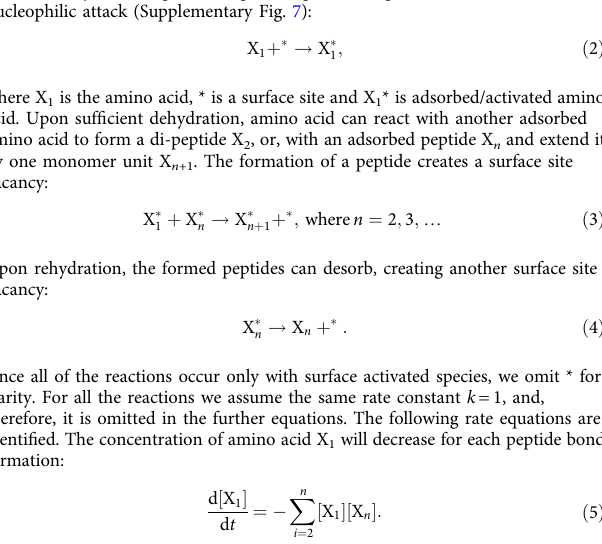
Fig. 5 Proposed mechanism for LDH supported peptide bond formation. a Upon dehydration, the N- and C-termini of adsorbed amino acids co-align, allowing the formation of a peptide bond. The newly formed di-peptide remains tethered via C-terminus only. The bond formation leads to the loss of charge, facilitating introduction of a new amino acid. The N-terminal of amino acid is then able to form a bond with the C-terminal of di-peptide, thus triggering further peptide growth. b A kinetic model of peptide growth upon multiple dehydrations — rehydration cycles. After a single dehydration, only dimers to hexamers are observed. Subsequent washing cycles lead